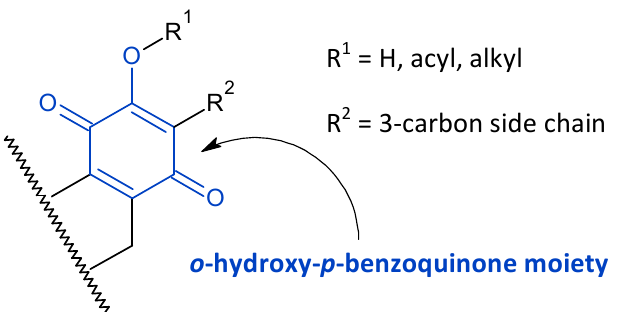
Figure 2. Royleanone skeleton.